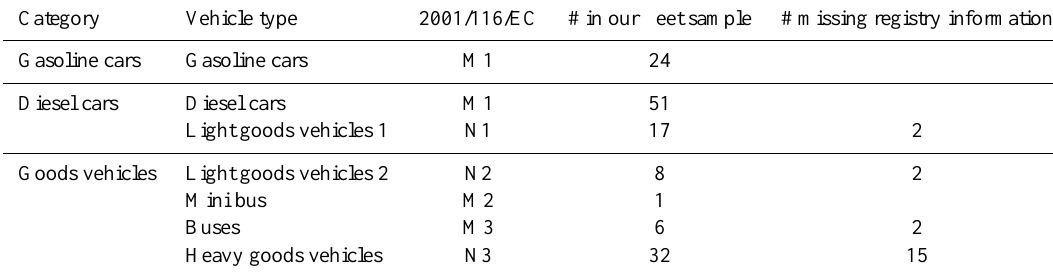
Table 2. Number of vehicle types in the sampled fleet, according their assigned categories.